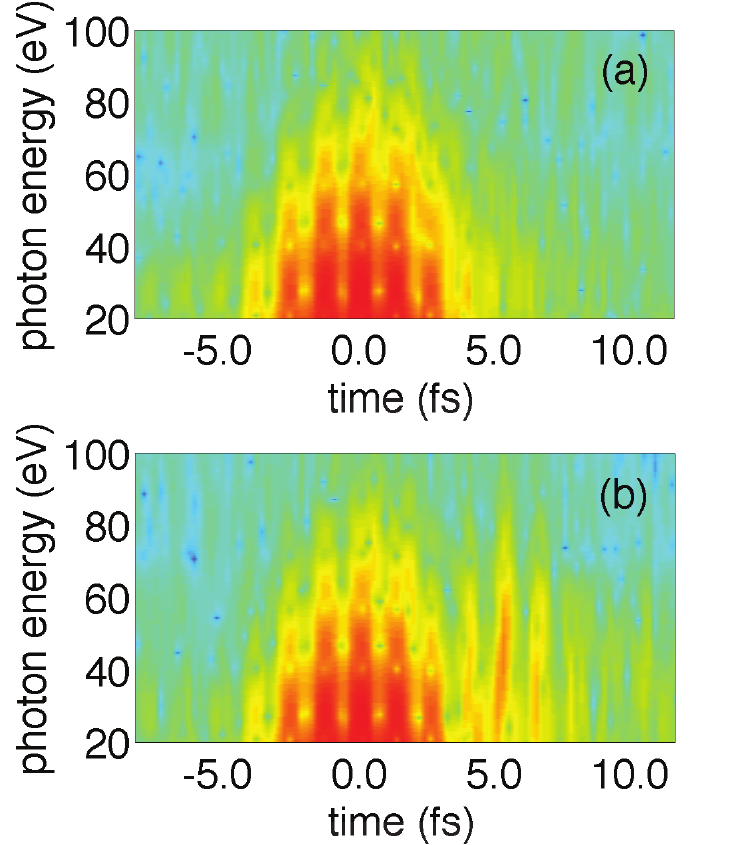
Figure 3. (Color online) Time-frequency analysis of the original ( a ) and optimized ( b ) spectra, for the case shown in Figure